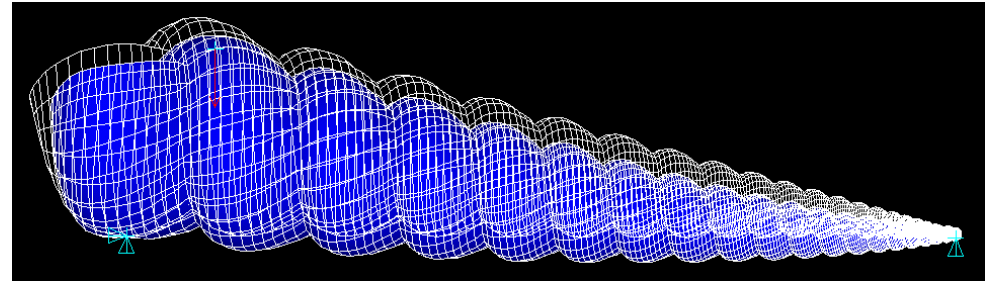
Figure 6. Typical deformation of the shell model as subjected to three-point bending. The pin ( bottom left ), roller ( bottom right ), and loading ( top left at highest point) boundary conditions are shown.